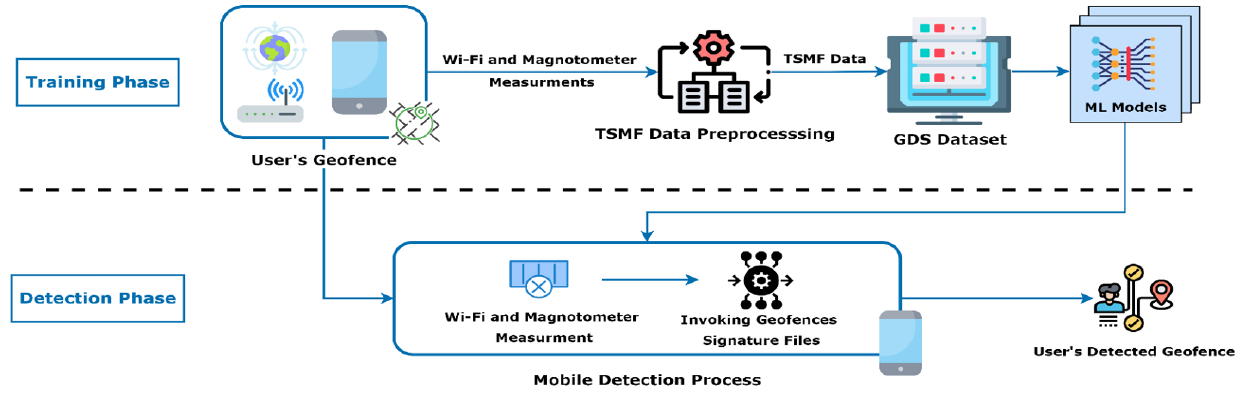
Figure 8. ML system operation diagram.